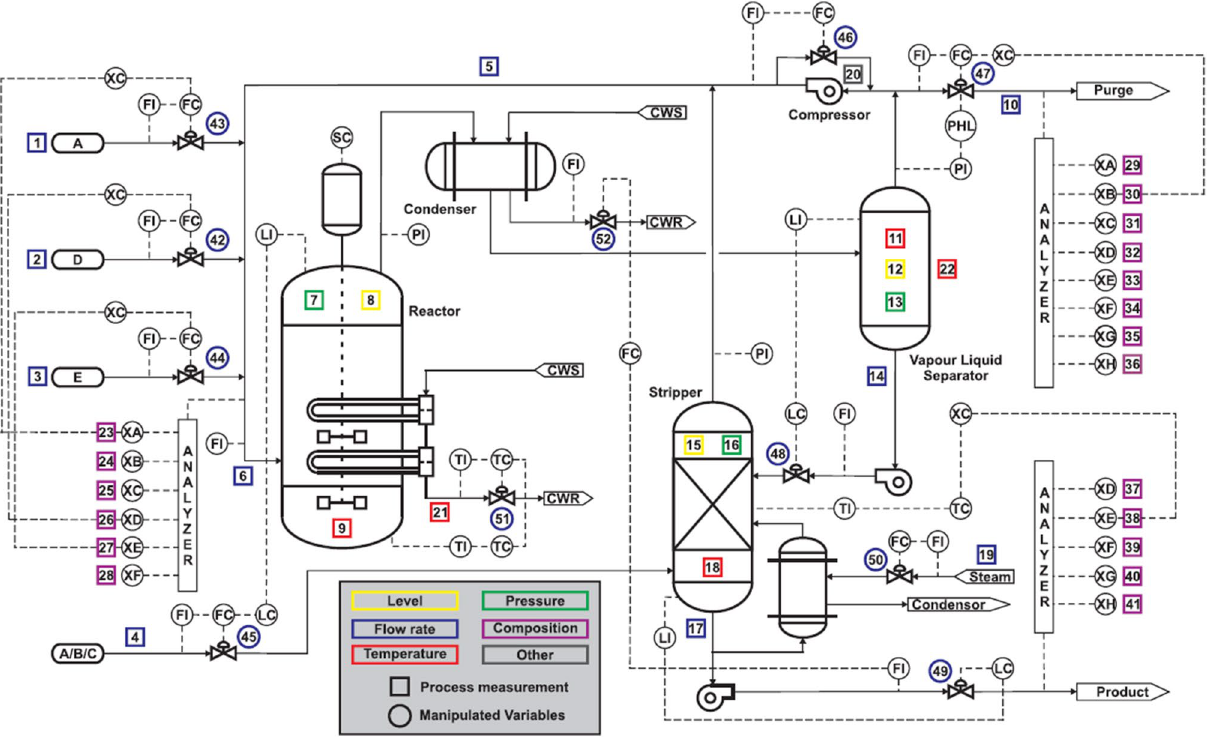
Figure 6. Schematic of the Tennessee Eastman process 33 .